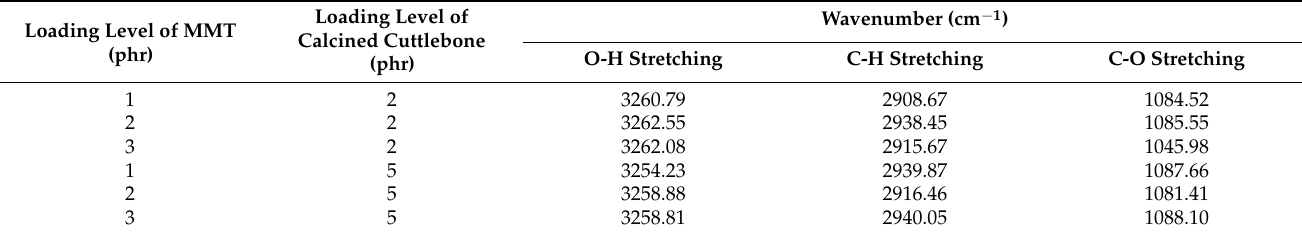
Table 2. Wavenumbers of its stretching type for all PVOH-calcined cuttlebone-MMT